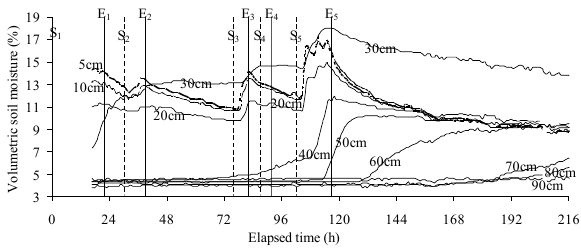
Fig. 7. The wetting front advance from 0:00 LT of 22 September to 0:00 LT of 1 October. Vertical lines of paired S and E represent the start (dashed line) and end (solid line) of individual rainfall respectively.